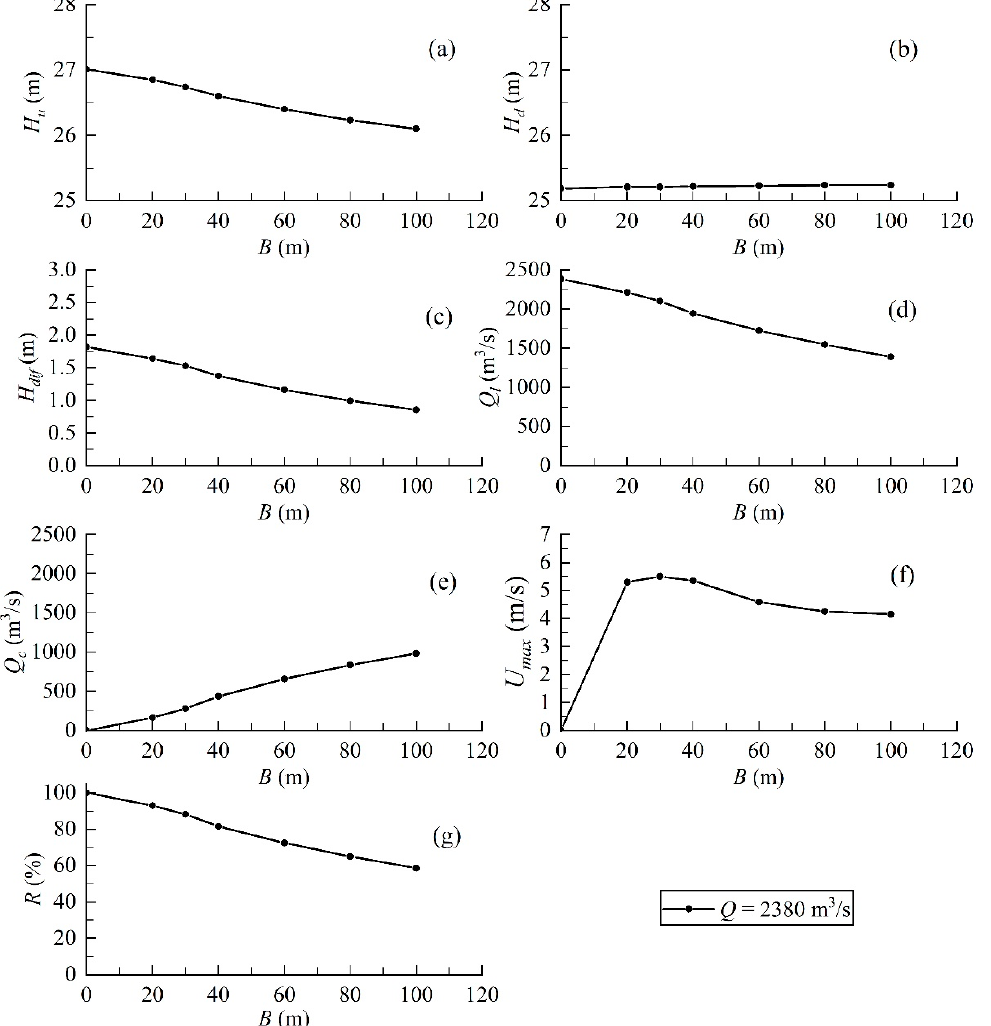
Figure 14. Numerical results of original scheme 3: ( a ) upstream water level; ( b ) downstream water level; ( c ) water level difference; ( d ) flow rate of low holes; ( e ) flow rate of closure gap; ( f ) maximum velocity; ( g ) split flow rate.